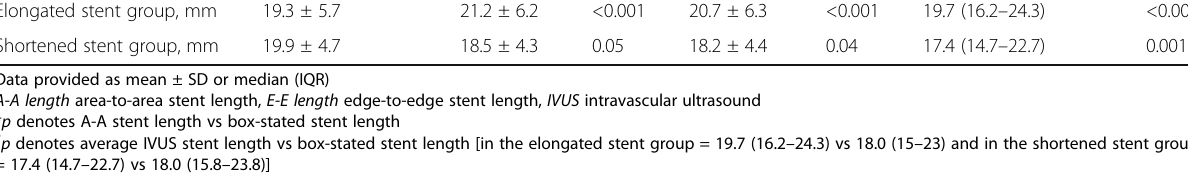
Table 5 IVUS stent lengths vs manufacturer box-stated stent length Box-stated length